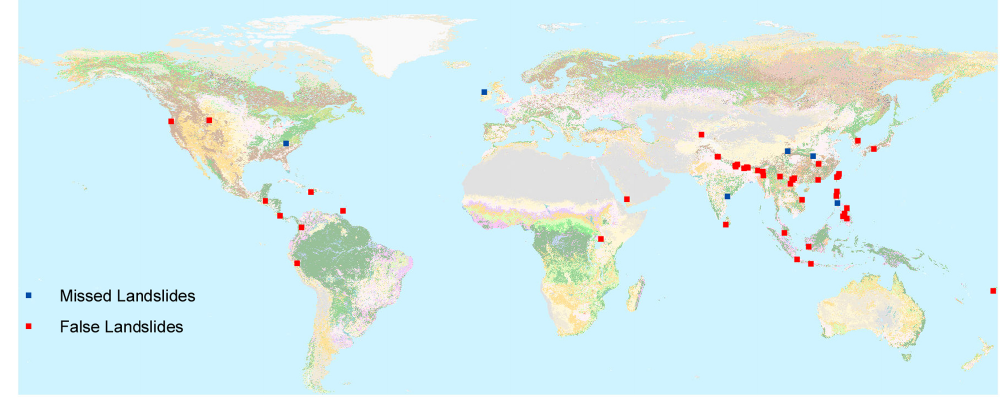
Fig. 9. False landslides (red squares) and missed landslides (blue squares) for the same iteration shown in Figure 8.